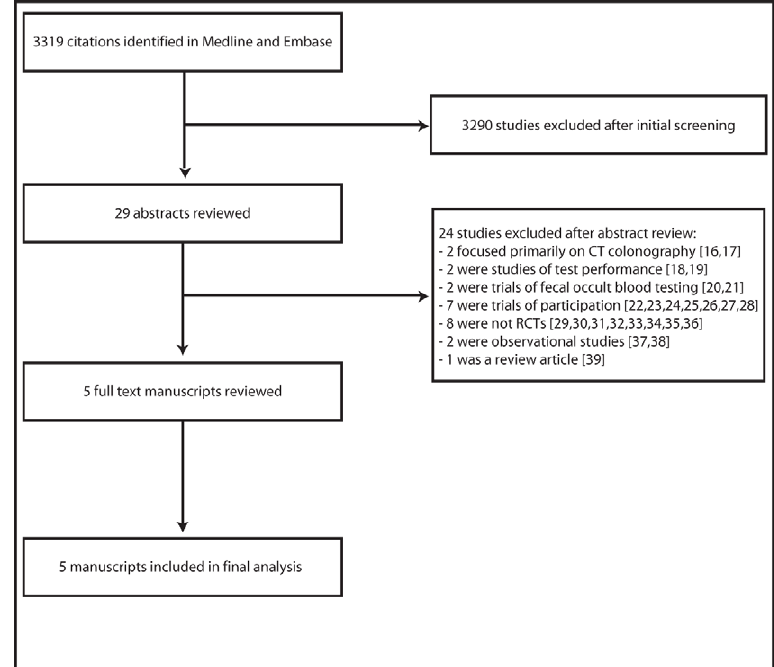
Figure 1. The literature search and selection process.